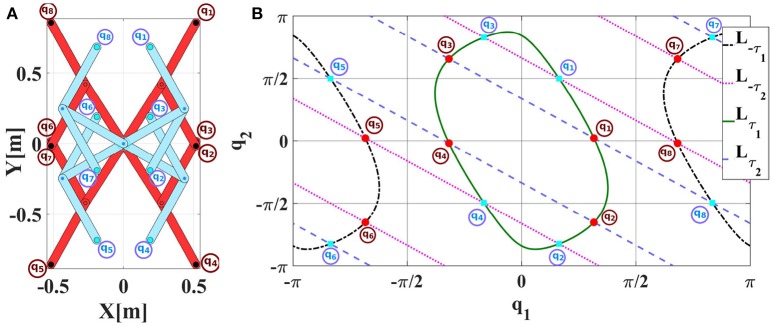
(A) Symmetric configurations of a 2R planar robot which require the same absolute static torque to be maintained. Configuration pairs in each configuration set illustrated in blue SA (and red SB, respectively) are primary symmetric to each other in the same set. The two sets are secondary symmetric to each other. Note that the manipulator is stretched out to the right in its zero configuration and that the gravity vector points downwards into negative y-direction. (B) Component-wise level sets Lτ1,Lτ2,L-τ1,L-τ2 of the 2R planar manipulator. The 16 intersection points constitute symmetric configurations. Their colors and numbers correspond to the configurations shown in Figure 2A. The numbers are based on Equation (11).